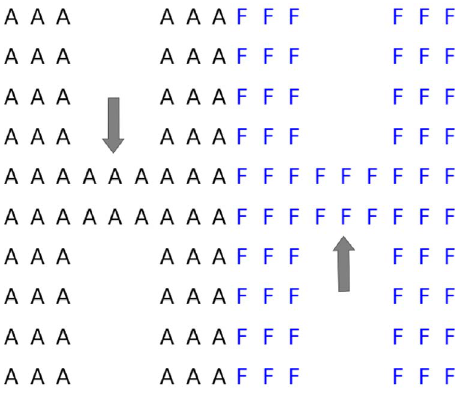
Figure 1. Starting shape for simulation. Letters and colors represent the true clustering. The chokepoints (gray arrows) create weakly linked sub-clusters that should not be fragmented.